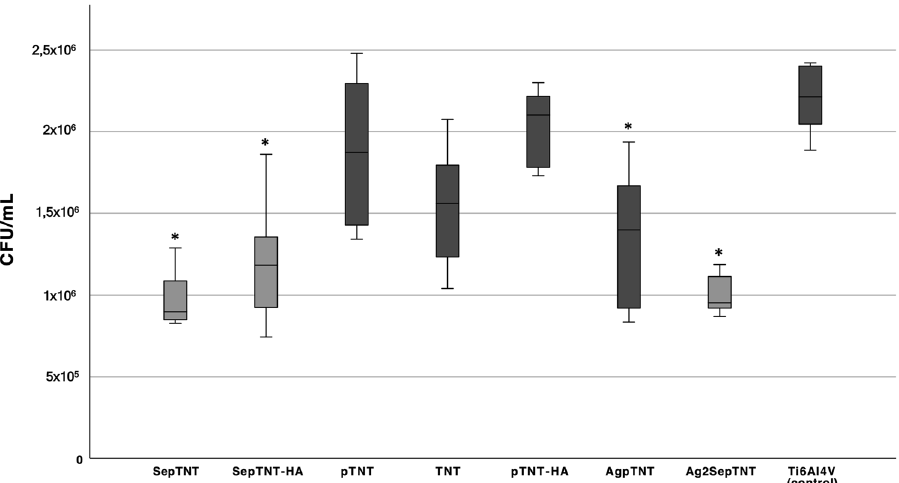
Figure 3. Colony forming units of S. epidermidis after 24 h of incubation on the surface of the modified and non-modified (control) titanium discs (* P < 0.05). selenium-incorporated phosphate-doped TiO 2 - nanotubes (SepTNT), selenium incorporated phosphate-doped TiO 2 -nanotubes with hydroxyapatite coating (SepTNT-HA), phosphate-doped TiO 2 -nanotubes (pTNT), titanium nanotubes (TNT), silver incorporated titanium phosphate-doped TiO 2 -nanotubes (AgpTNT), silver-selenium incorporated phosphate-doped TiO 2 - nanotubes (Ag 2 SepTNT) and non-modified control (Ti6Al4V).